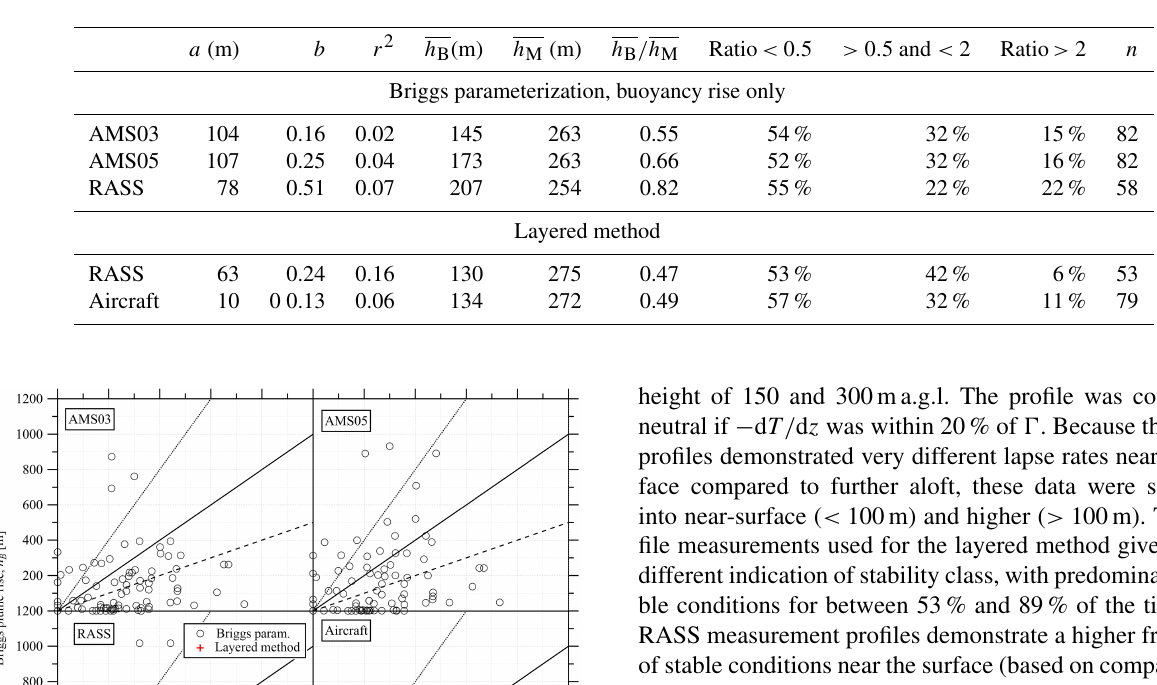
Table 3. Statistics comparing the predicted-to-measured plume rises using both the Briggs parameterization (Eqs. 1–6) and the layered method (Eq. 7). The intercept ( a ) and slope ( b ) of least-squares fit, average calculated ( h B ) and observed ( h M ) plume rises, ratio of all values ( h B /h M ), correlation coefficient ( r 2 ), fraction of individual ratios of h B,i : h M ,i below the 1 : 2 ratio ( < 0 . 5), within a factor of 2 ( > 0 . 5 and < 2), and above the 2 : 1 ratio ( > 2), and the number ( n ) of plume-to-stack matches used for each comparison.